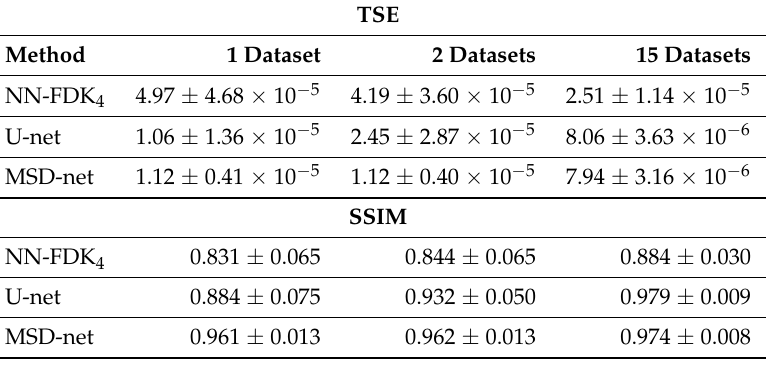
Table 6. Average and standard deviation of the quantitative measures computed over 20 Fourshape phantoms for varying training scenarios. The reconstruction problems have an emitted photon count of I 0 = 256 and N a = 360 projection angles. The NN-FDK reconstruction time is 4-10 times lower than U-net and